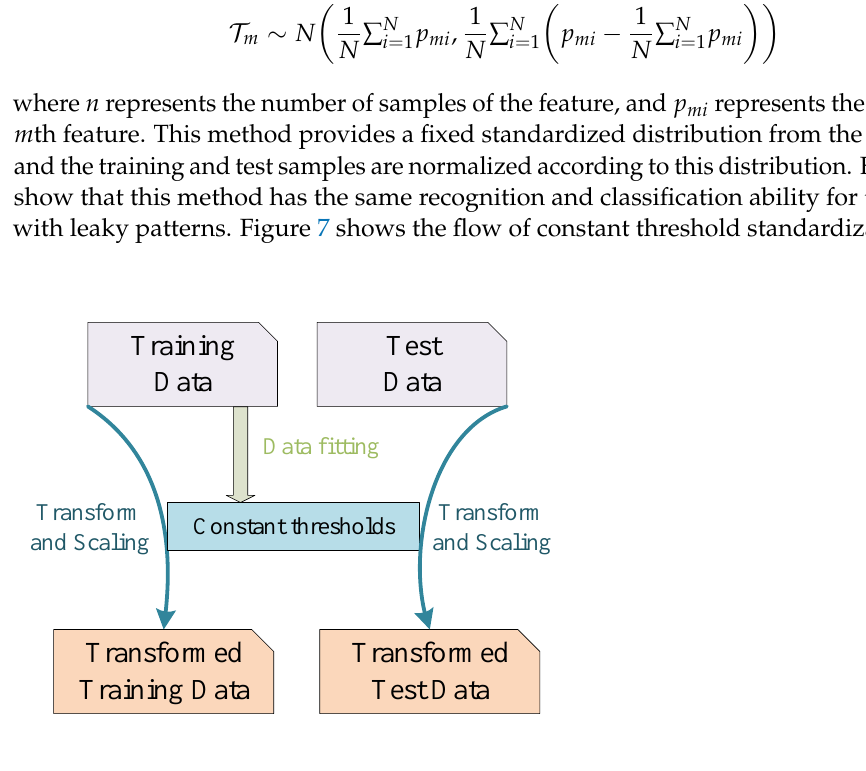
Figure 7. Fixed distribution normalization. The fixed distribution extracted from the training set is used to translate and zoom all